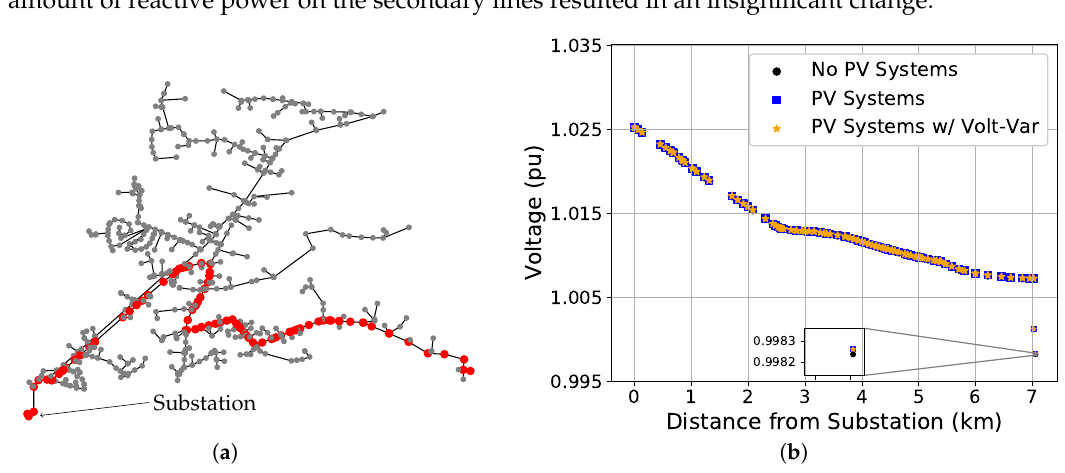
Figure 6. The voltage profile from the substation to a single phase PV system at the edge of the K1 feeder. The PV generation on the secondary system caused a very small increase in voltage and an even smaller change in voltage when the VVC was enabled. ( a ) feeder map and path for voltage profile; ( b ) the voltage profile for primary and secondary lines with and without PV and with Volt-Var Curve control.